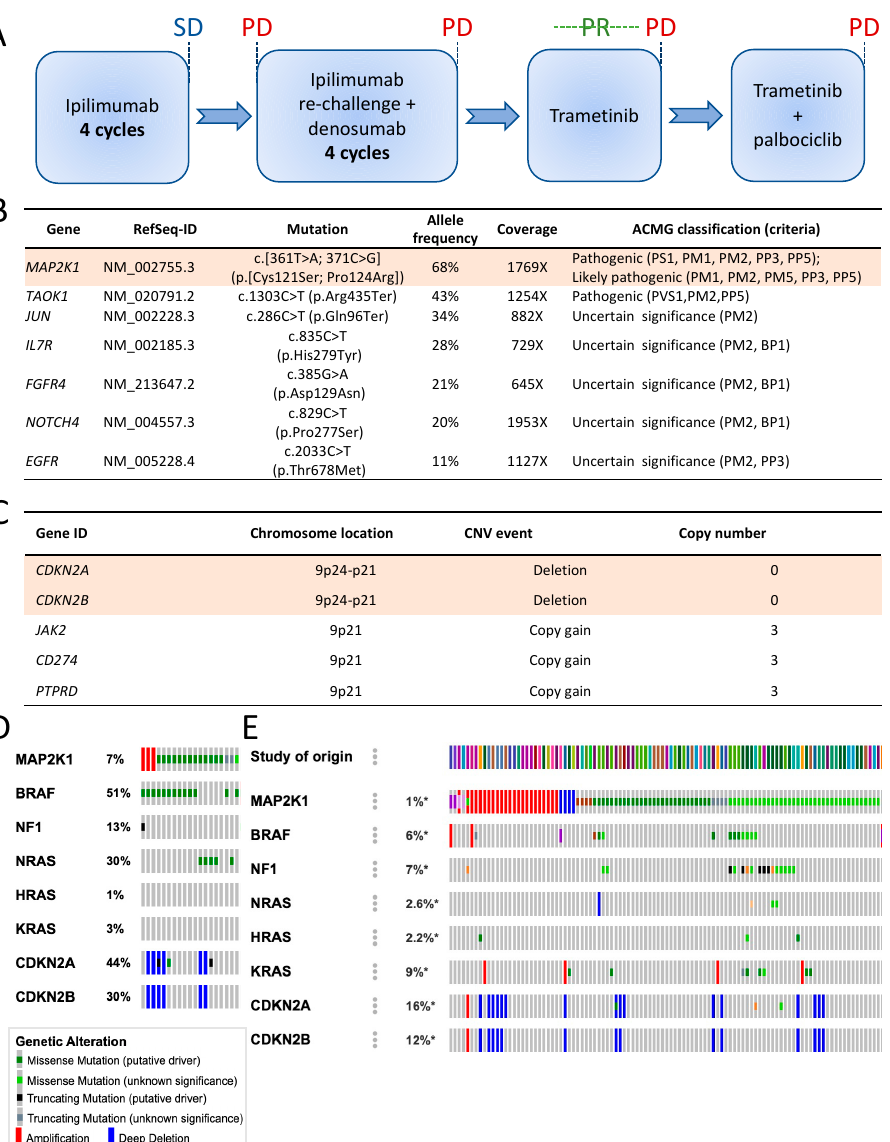
Figure 1. Treatment and analysis of the patient data. ( A ) Schematic figure showing the treatments received by the patient from the diagnosis of metastatic melanoma; ( B ) List of mutations detected by NGS of pre-treatment biopsy; ( C ) Selection of copy number variations detected by next-generation sequencing of pre-treatment biopsy; ( D ) Oncoprint analysis of MAP2K1-mutant melanoma patients of the TCGA melanoma (SKCM) cohort for other MAPK genes and CDKN2A/B ; ( E ) Oncoprint analysis of MAP2K1 mutant cancer patients of the TCGA cohorts except for melanoma for other MAPK genes and CDKN2A/B . * is a symbol used for nonsense and frameshift